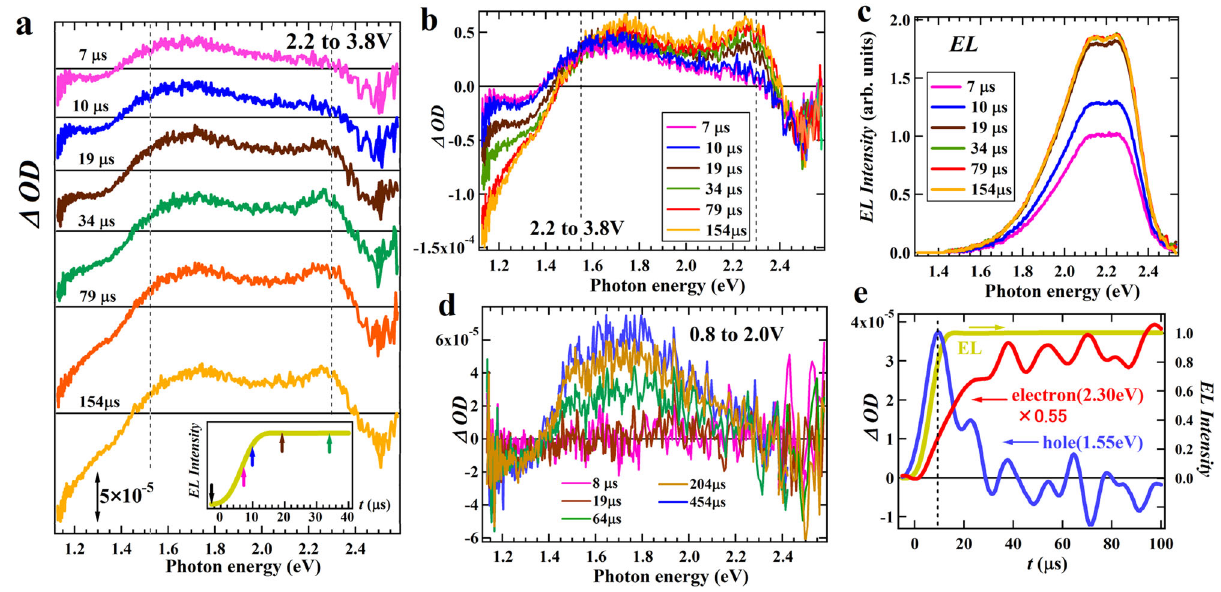
Fig. 4 | Operation dynamics of LEC. a Time-resolved BM spectra of the SY-LEC obtainedwhenthebiasisraisedfrom2.2Vto3.8Vwherethebaselineswereshifted foreach spectrum representedbythe horizontalstraight line.The inset isthe time evolution of EL intensity, with arrows indicating the baseline point (black) and severaltimepointsatwhichtheBMspectrumwasmeasured(7 μ s,10 μ s,19 μ s,and 34 μ s). b The same time-resolved BM spectra as in a represented with a uni fi ed